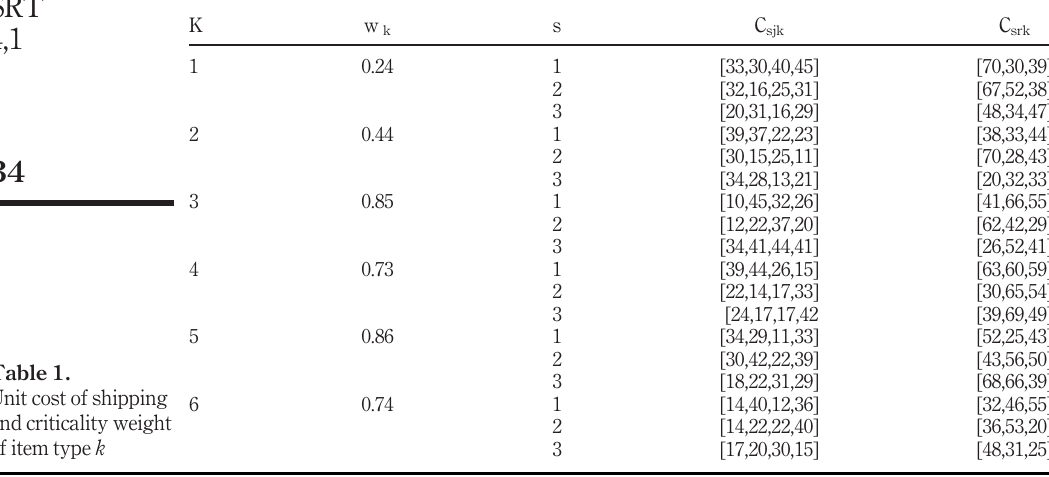
Table 1. Unit cost of shipping and criticality weight